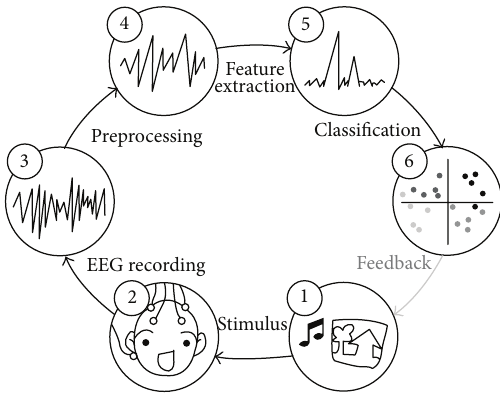
Figure 4: The process of emotion classification [19].